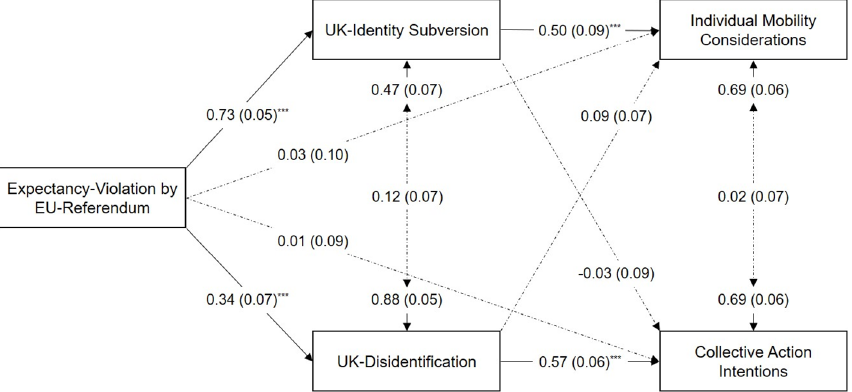
Note. Solid lines represent significant relations, dashed lines represent non-significant